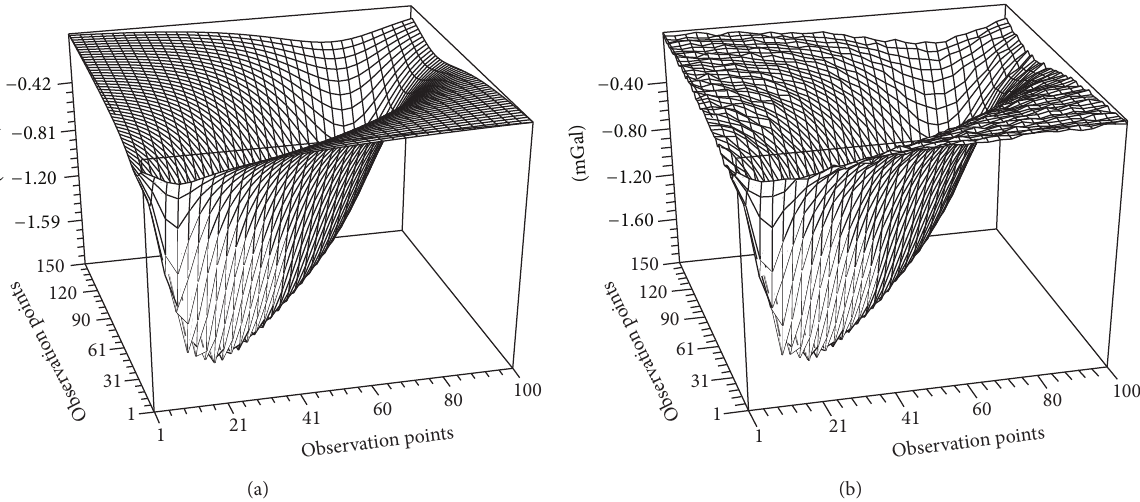
Figure 16: Component 𝑧 of the vector 𝐺(𝐺 𝑧 ) , (a) calculated in double precision, (b) calculated in single precision. Apparently no significant differences are seen between the graphs; however there is the introduction of roughness in single precision.